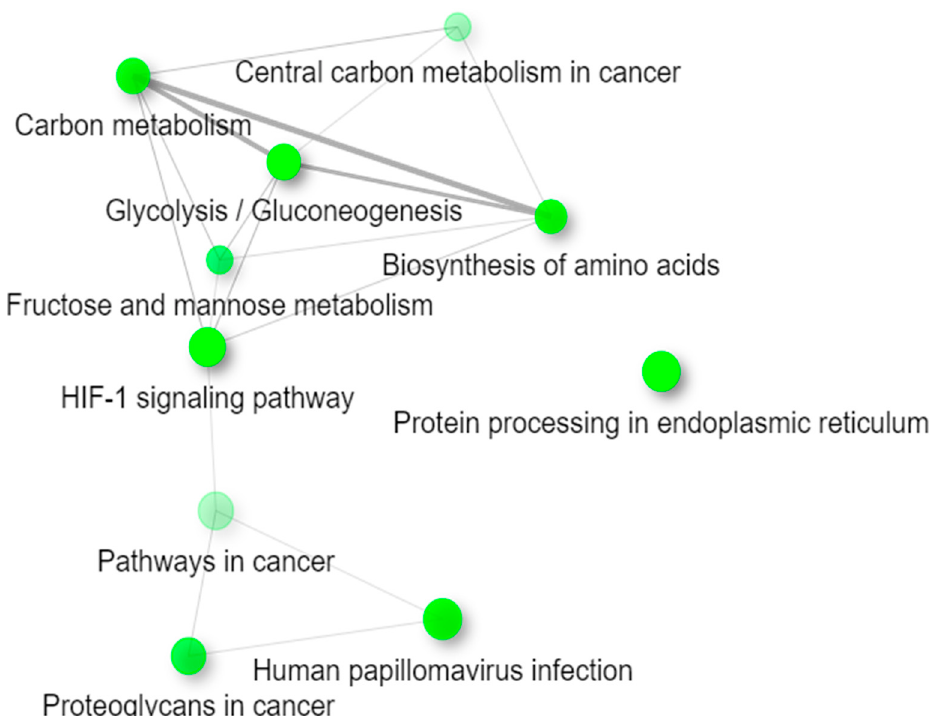
Figure 3. Web Diagram of the top 10 most significant KEGG pathways. This diagram represents how the differentially expressed genes listed in the enriched Kyoto Encyclopedia of Genes and Genomes (KEGG) pathways in Table 1 are connected. Two pathways (nodes) are connected if they share 20% or more genes. Darker nodes are more significantly enriched gene sets, and larger nodes represent larger gene sets. Thicker lines represent more overlapped genes between the pathways.